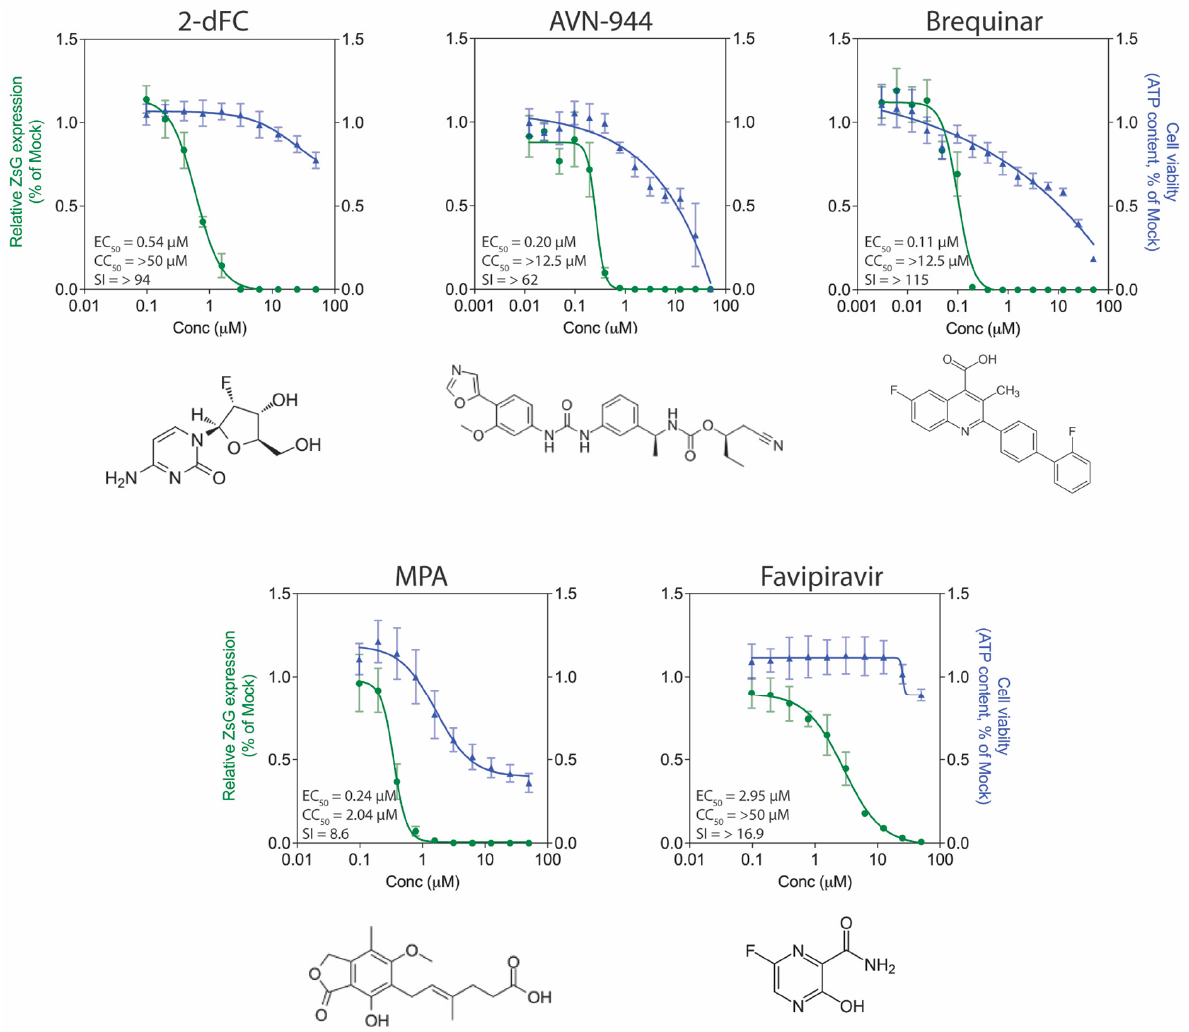
Figure 2. Antiviral activity of select compounds targeting viral replication processes. Concentration-response curves in Huh7 cells infected with rLUJV/ZsG (MOI 0.1) after being treated 1 h prior with 2 (cid:48) -deoxy-2 (cid:48) -fluorocytidine (2-dFC), AVN-944, brequinar, mycophenolic acid (MPA), or T-705. Relative ZsG expression is shown in green and cell viability in blue. Values were normalized to mock-treated (DMSO only) infected cells. Each point represents the mean of quadruplicate wells, with error bars indicating standard deviation; graphs are representative of at least 3 independent experiments. Associated EC 50 , CC 50 , and SI values are given, along with the chemical structure of each